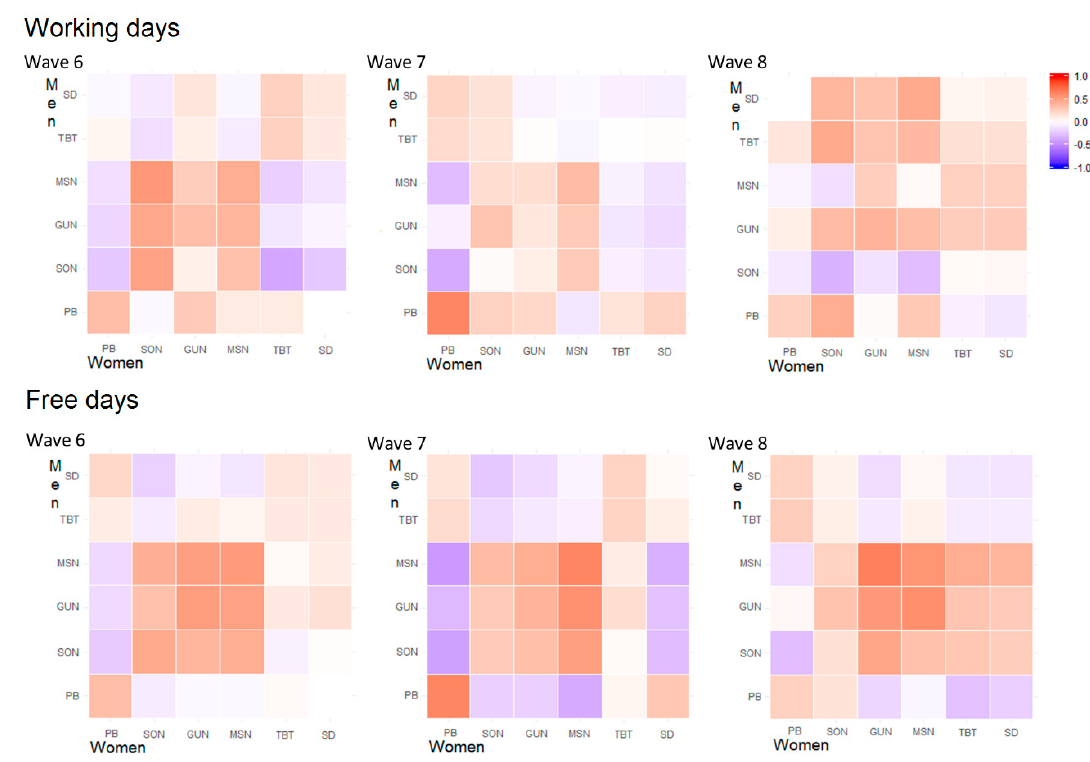
Figure 1. Heat maps of Pearson correlation coefficients of sleeping features and relationship satisfaction scores at different time points for women vs. men. Note: SCC: Child sleeping quality score, PB: Partner relationship score, SD: Sleep duration, TBT: Time spent in bed, MSN: Middle sleep, GUN: Time getting out of bed, SON: Sleep onset .